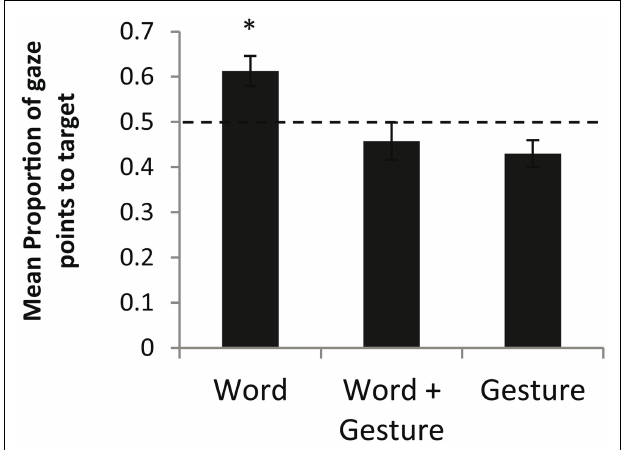
FIGURE 2 | Mean proportion of gaze points to the target object relative to the non-target object. Note: Asterisk indicates significant performance above chance, p < 0.05.